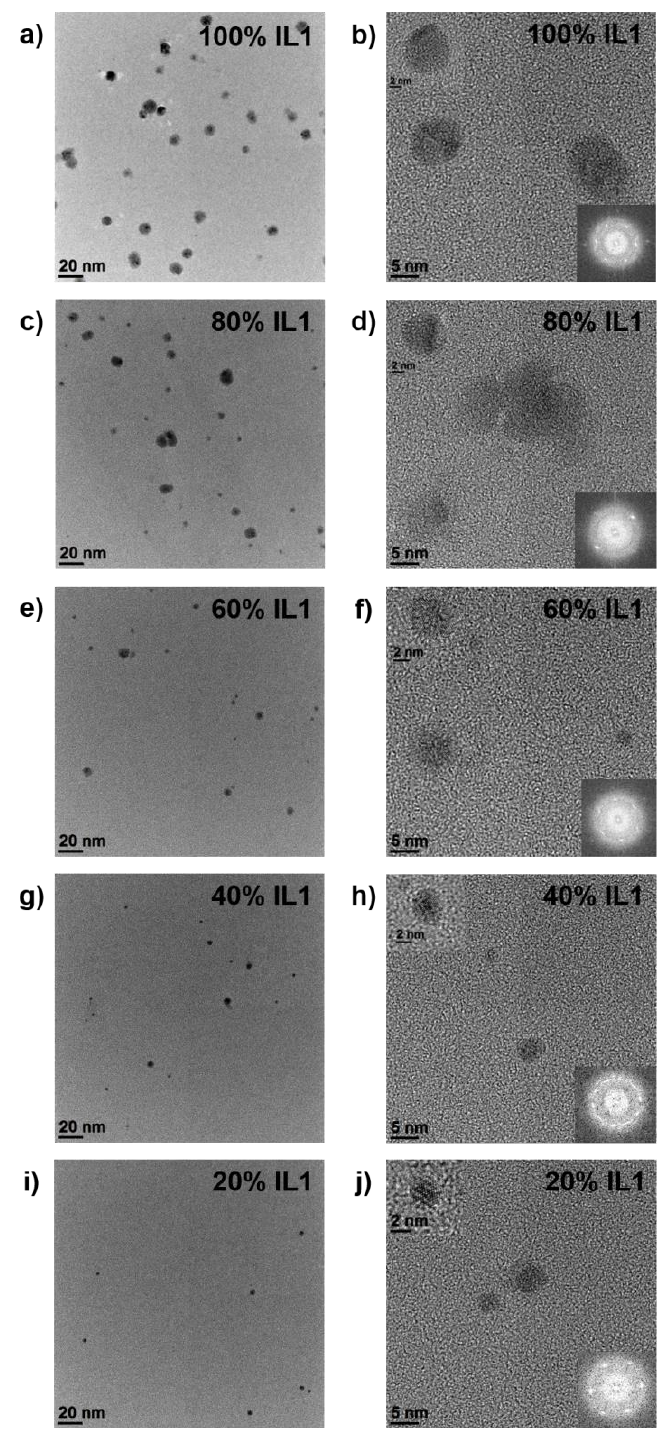
Figure 2. Overview of TEM results of Ag NPs in IL1 diluted with anisole in 20 vol.% steps. Ag NPs in pure IL1 are shown in ( a ) and ( b ). Ag NPs in IL / anisole mixtures of 80 vol.% IL1 and 20 vol.% anisole are shown in ( c ) and ( d ), 60 vol.% IL1 and 40 vol.% anisole in ( e ) and ( f ), 40 vol.% IL1 and 60 vol.% anisole in ( g ) and ( h ), and 20 vol.% IL1 and 80 vol.% anisole are shown in ( i ) and ( j ). Fast Fourier Transformation (FFT) and corresponding high-resolution TEM (HRTEM) images of the NPs are displayed as insets in the small overview images.